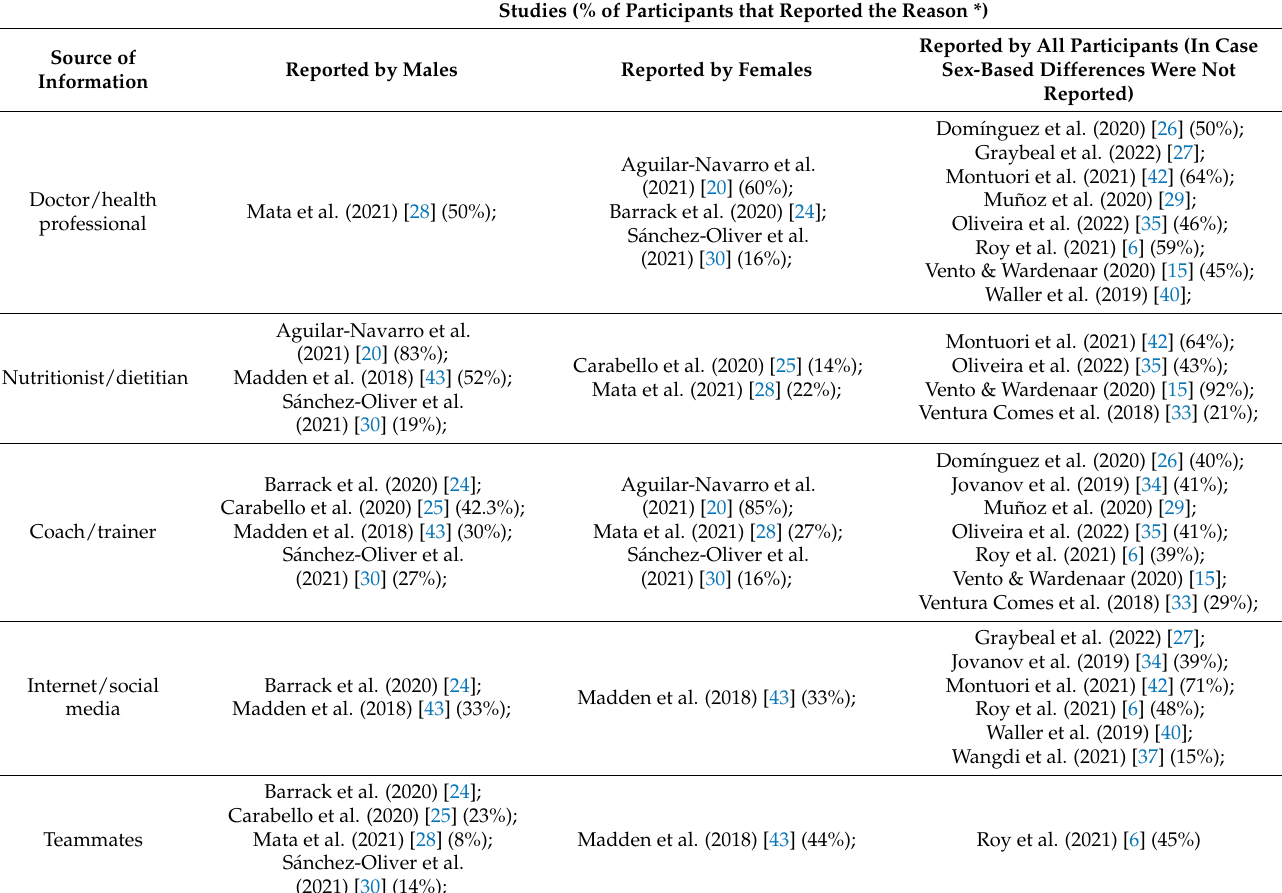
Table 3. Sources of information on dietary supplements reported by